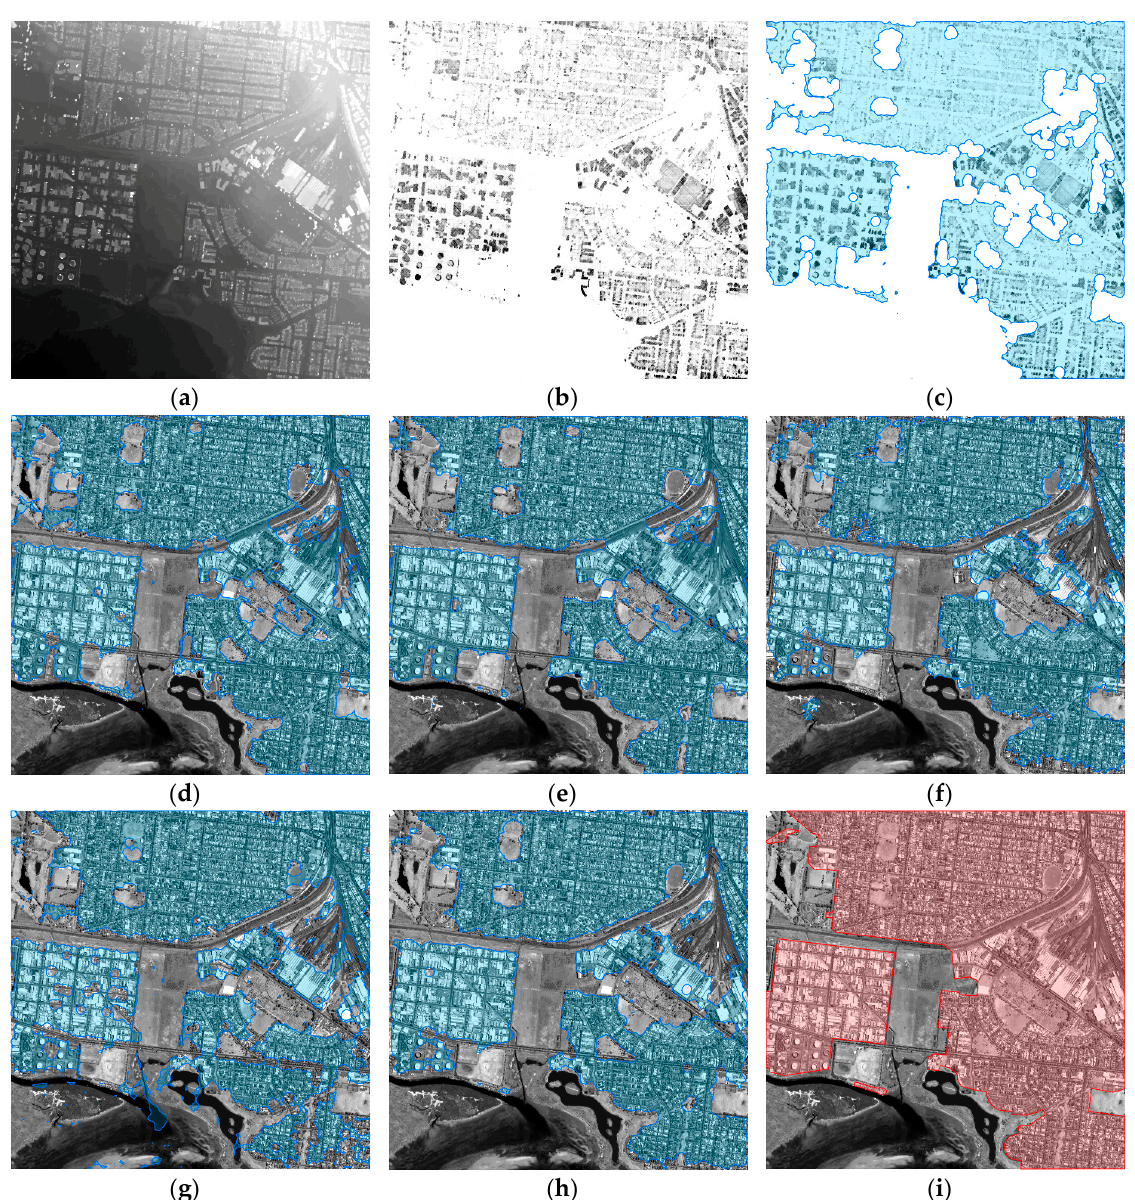
Figure 10. Results for stereo pair 1. ( a ) Disparity image. ( b ) SPDI image. ( c , d ) SPDI-based built-up area results superposed on SPDI image and Image 1 of the stereo pair, respectively. ( e ) Built-up area results obtained using the combination of SPDI and Gabor. ( f – h ) Built-up area results obtained using the methods [22], [36], and [13], respectively. ( i ) Ground truth map. Built-up area results obtained from a single image using the method [22] are shown in subfigure